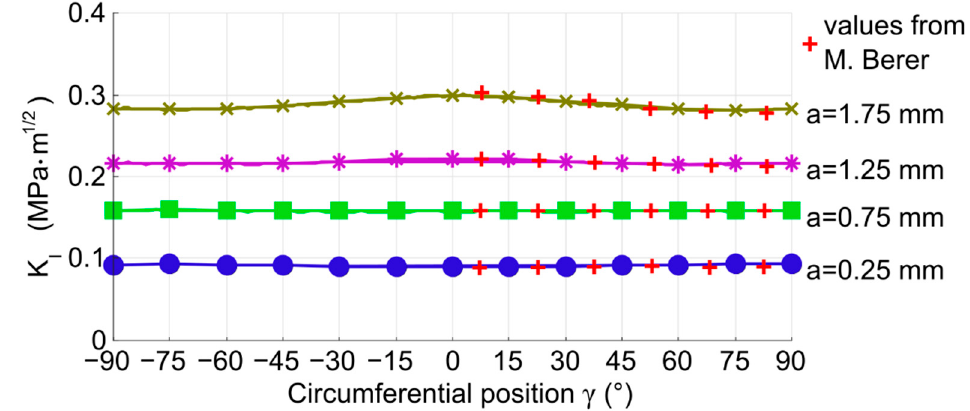
Figure 5. Comparison of K I values from Berer et al. [3] and from the newer model described in this paper. The values from the newer model were estimated by domain integral (solid lines) and node deformations (separate points).